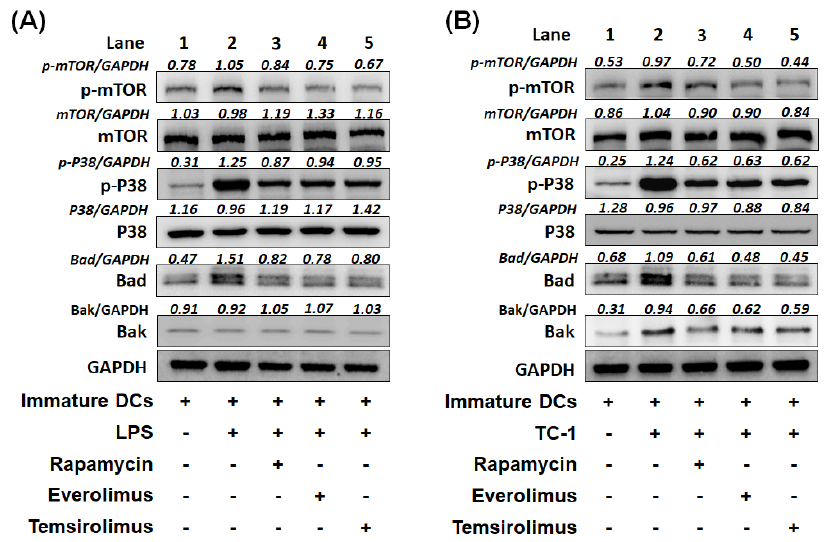
BMM-derived DCs ( p < 0.001, n = 3).